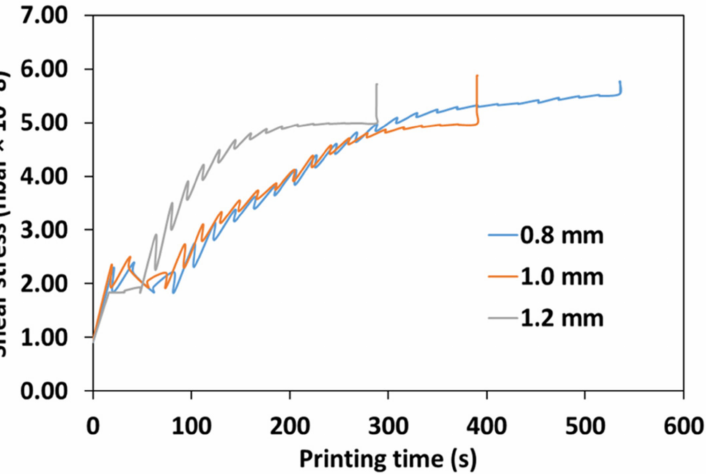
Figure 16. Simulated result of stress distribution during the printing process of rice paste based on nozzle